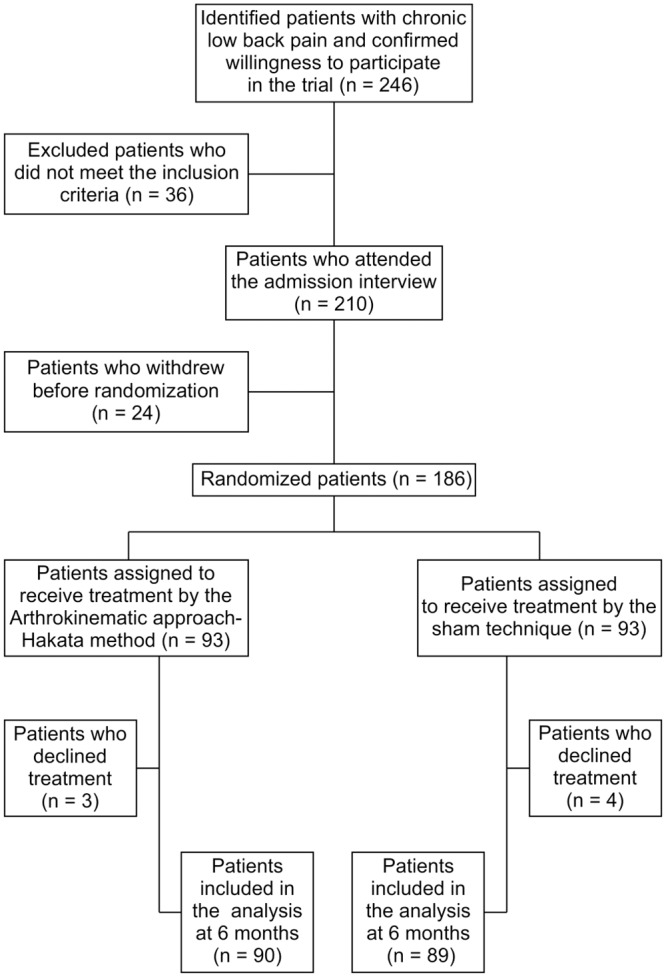
Study flow diagram.